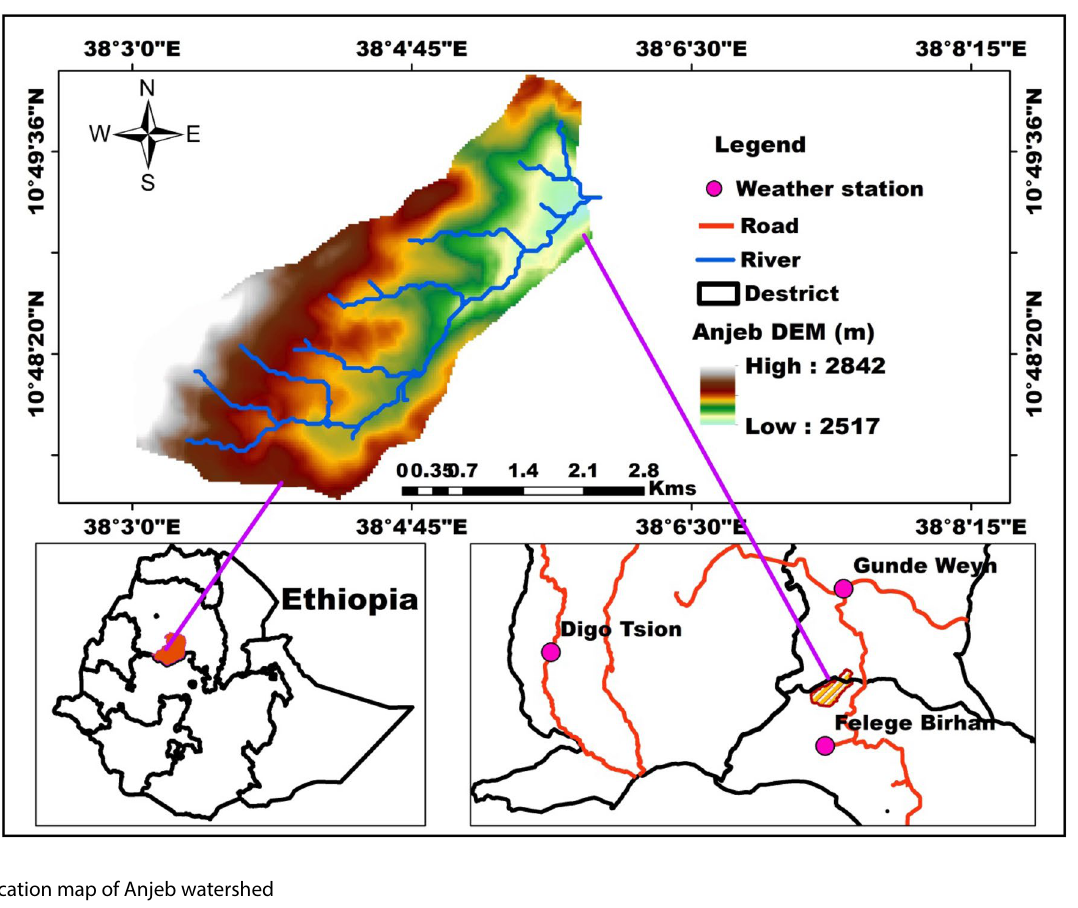
Fig. 1 Location map of Anjeb